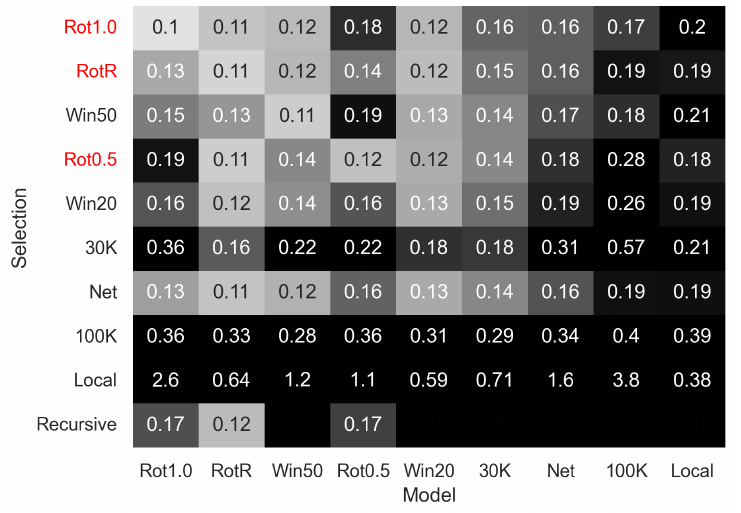
Figure 10. Error heatmap of all trained models evaluated with the different batch selection strategies. Selections written in red are